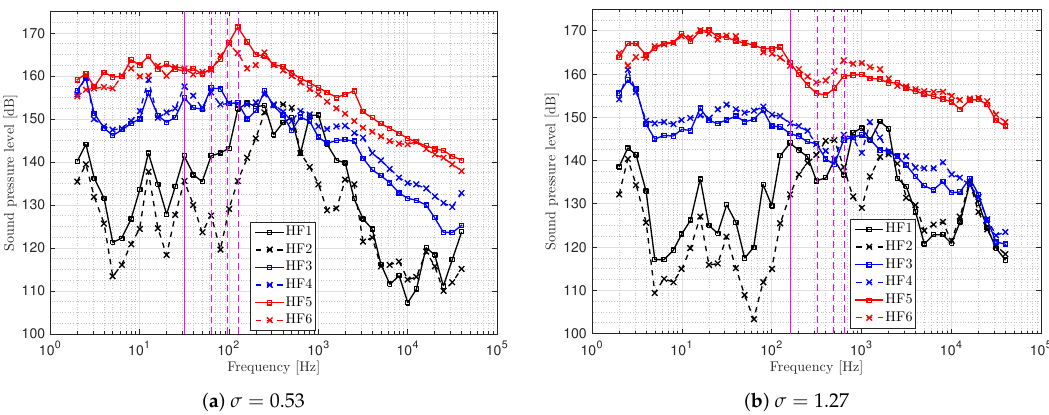
Figure 14. Sound pressure level measurements inside the cavitation tunnel with different hydrophone arrangements. The magenta vertical lines denote the predicted cavitation shedding frequency and its harmonics. The measurement results were reproduced with permission from Rhena Klose